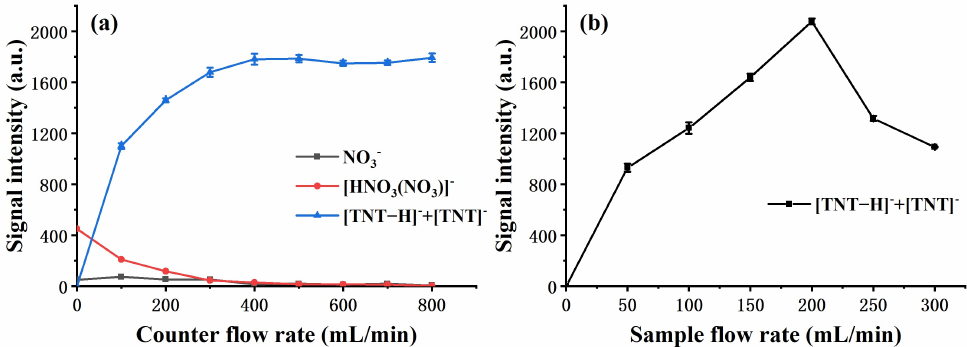
Figure 3. Effect of the flow rate ( a ) signal intensity of 1 ng TNT, [HNO 3 (NO 3 )] − , and NO 3 − versus counter flow rate; ( b ) signal intensity of 1 ng TNT versus sample flow